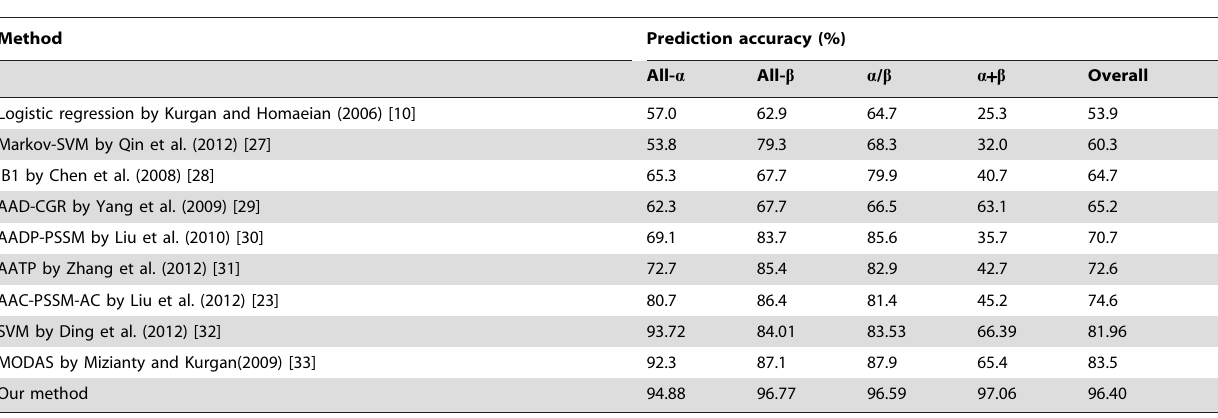
Table 3. Performance comparison of different methods on 1189